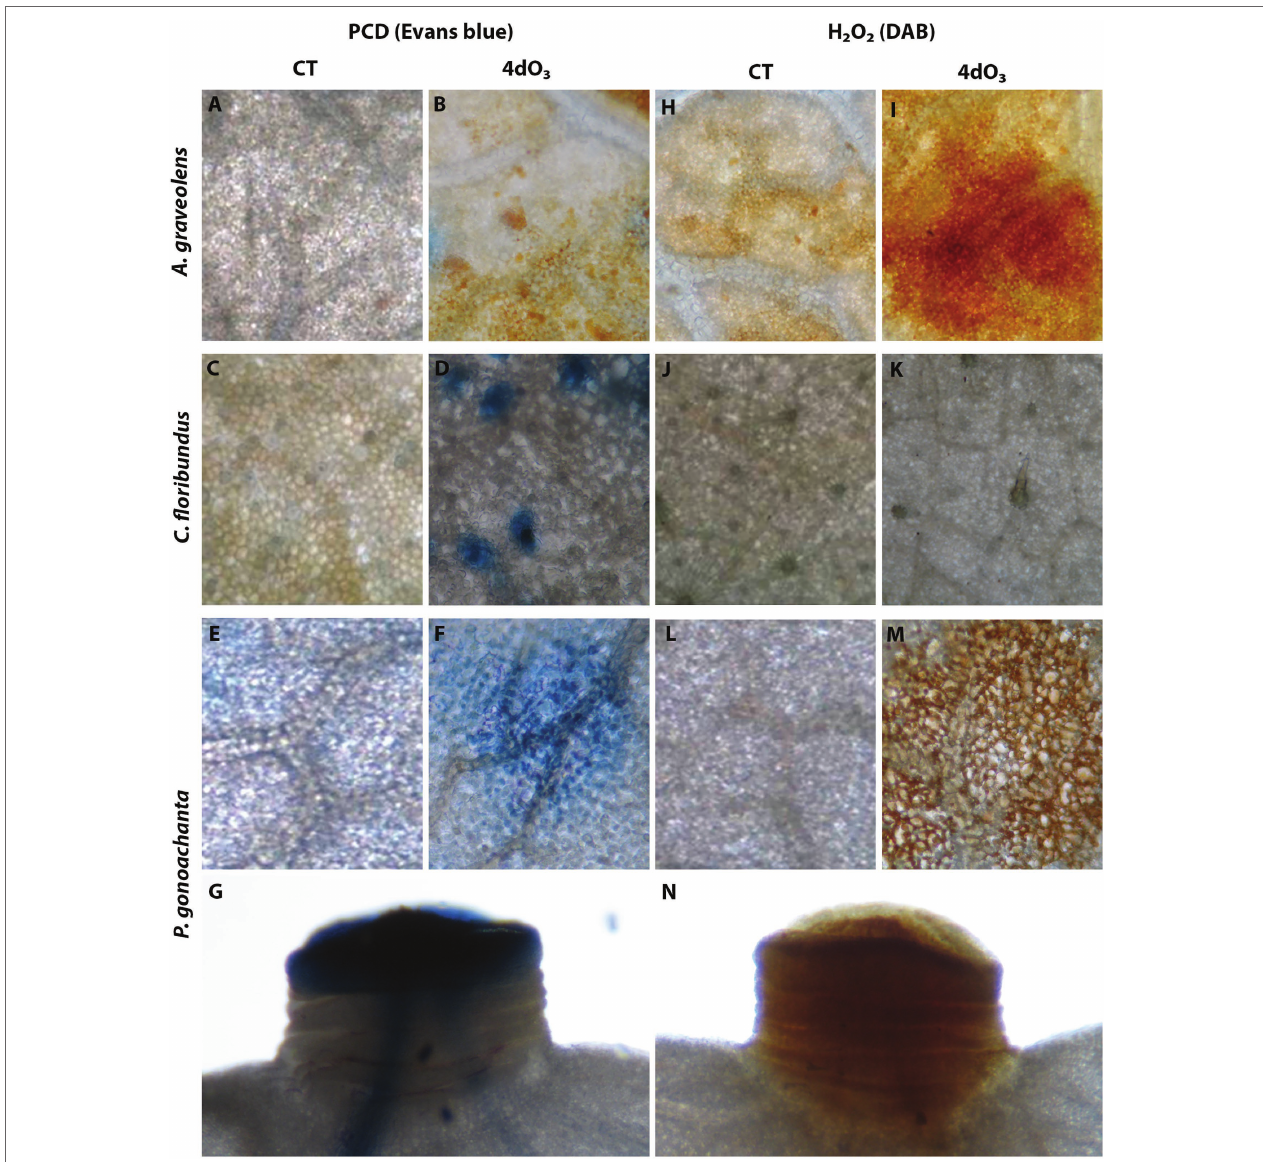
FIGURE 1 | Localization of programmed cell death (PCD) visualized by Evans blue staining. (A,B) Astronium graveolens , with PCD not observed in CT (A) or 4dO 3 samples (B) ; (C,D) Croton floribundus, with PCD, observed in palisade parenchyma cells of 4dO 3 samples (D) but not in CT samples (C) ; (E,G) Piptadenica gonoacantha with PCD observed in palisade parenchyma cells of 4dO 3 samples (F) but not in CT samples (E) and the leaf pulvinus (G) . H 2 O 2 deposits brown- stained by DAB. (H,I) Astronium graveolens, with H 2 O 2 observed in palisade parenchyma cells of 4dO 3 samples (I) but not in CT samples (H) ; (J,K) C. floribundus, with H 2 O 2 not observed in CT (J) or 4dO 3 samples (K) ; (L–N) Piptadenica gonoacantha with H 2 O 2 observed in palisade parenchyma cells of 4dO 3 samples (M) but not in CT samples (L) and the leaf pulvinus (N) . A–F and H–M , scale bars = 150 μ m. G,N , scale bars = 250 μ